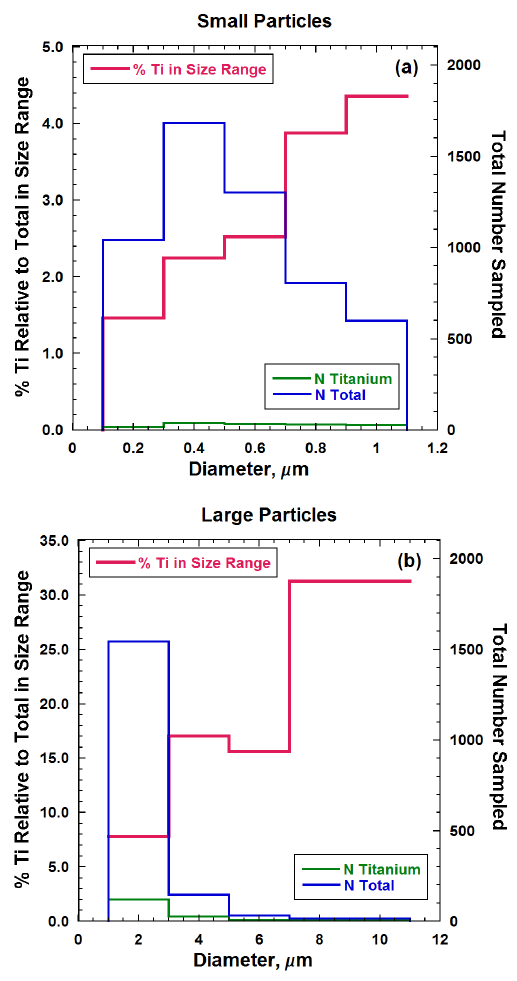
Fig. 12. The percent (red) of titanium particles relative to the to- tal number of CVI residual samples in different size ranges. Also shown is the total number of particles (blue) and those containing titanium (green.) Smaller particles are shown in (a) and larger ones in (b) . Diameter is the average of physical length and width as mea- sured via